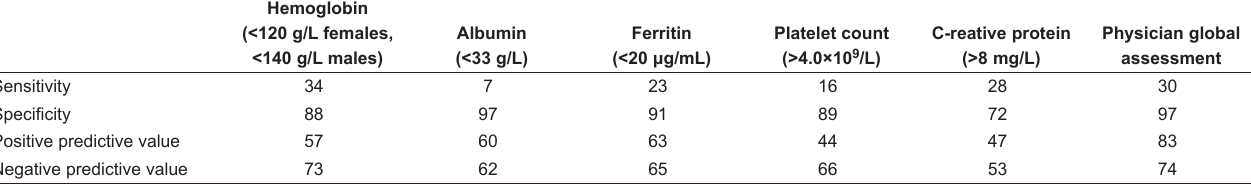
TAble 4 Association of abnormal laboratory data with endoscopy as the gold standard (moderate-severe disease)